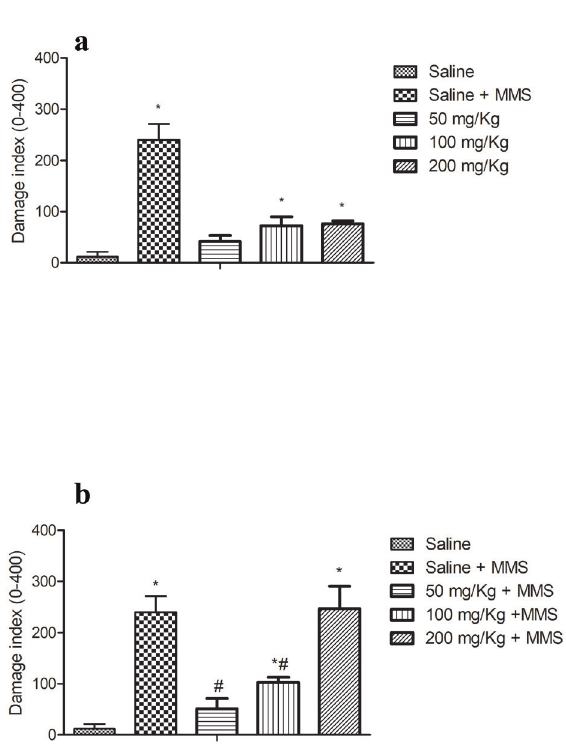
Figure 2 - Genotoxic ( a ) and Antigenotoxic ( b ) effects of different doses of H. acetosella in the blood cells of mice. * p < 0.05 compared with saline; # p < 0.05, compared with saline plus MMS, using ANOVA and Tukey